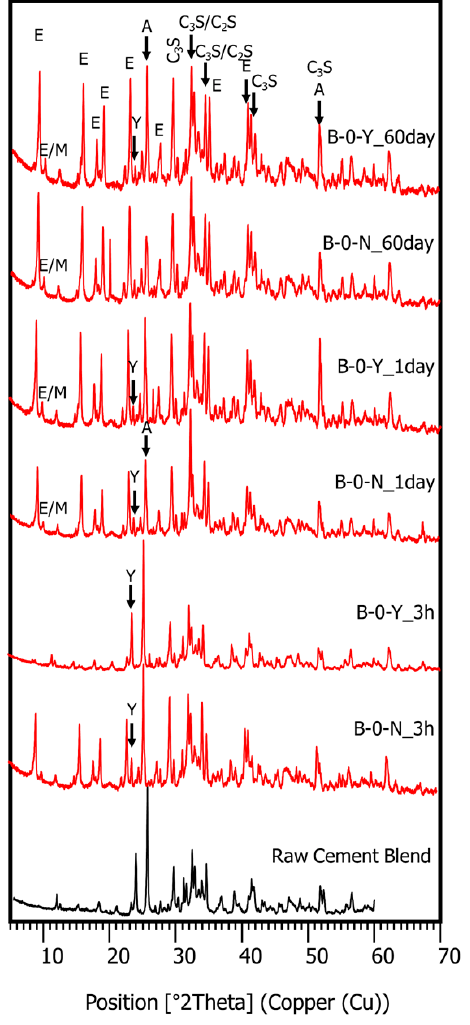
Figure 8. The XRD patterns of the cement pastes without a polymer (B-0-N, B-0-Y) at 3 h, 1 day, and 60 days.